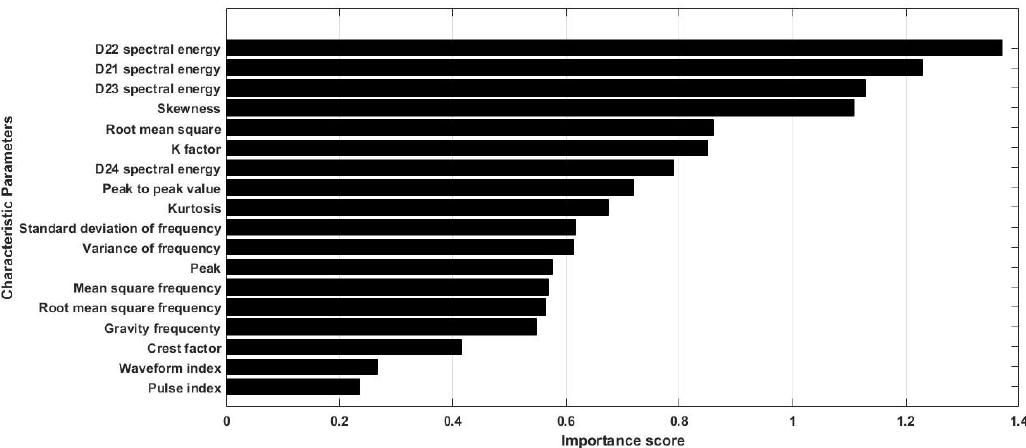
Figure 8. Relationship between OOB (Out-of-Bag) error and number of decision trees.